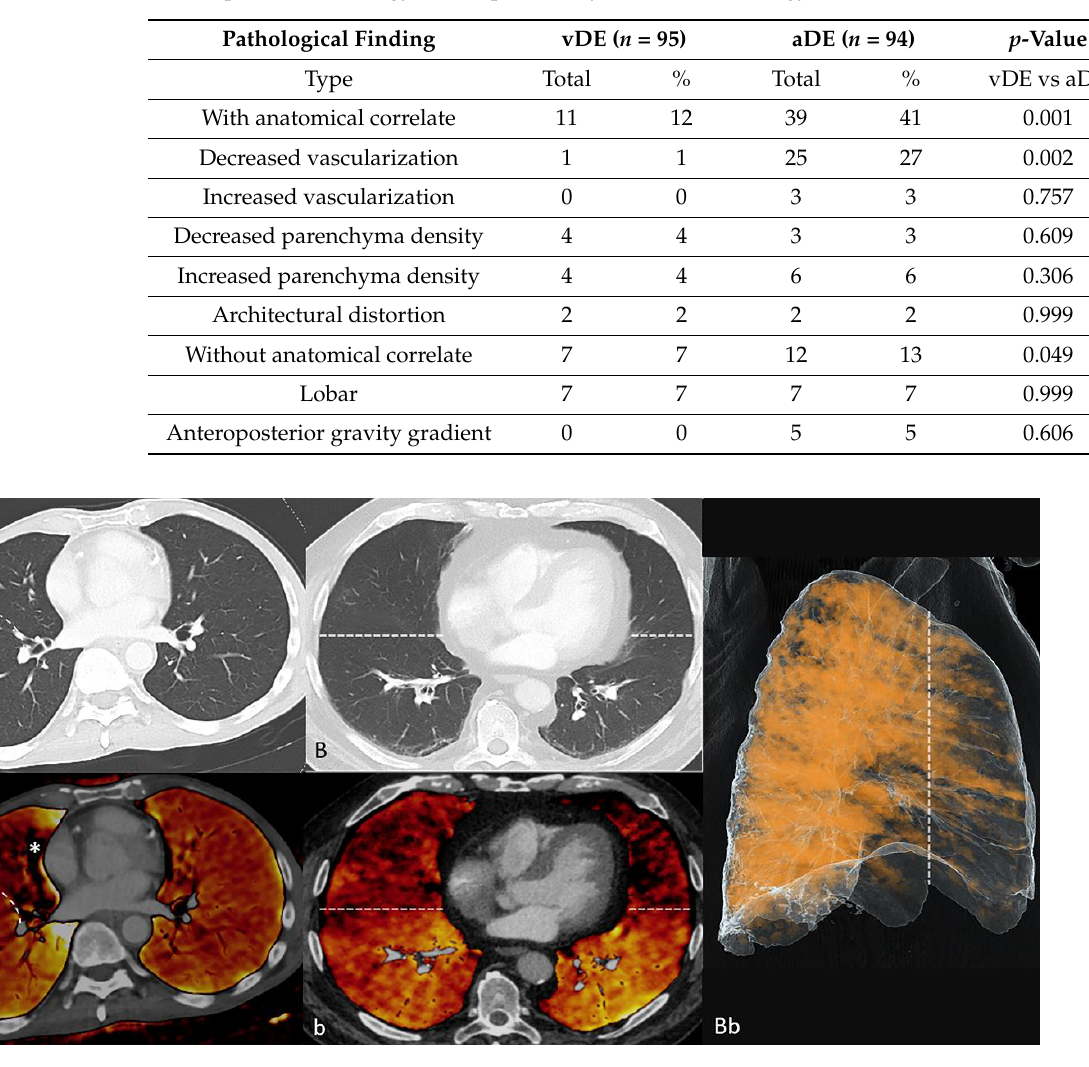
Table 4. Amount of perfusion relevant pathological findings in total and as percentage of patients within portal venous (vDE—portal-venous thoraco-abdominal Dual Energy CT) and pulmonary arterial phase Dual Energy (aDE—pulmonary arterial Dual Energy CT).